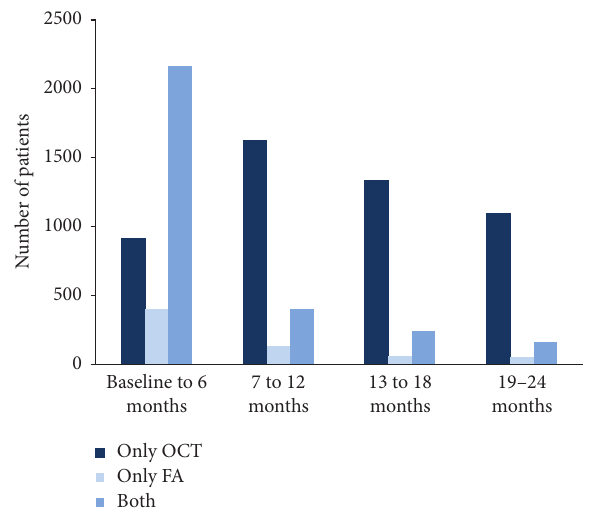
Figure 1: Number of patients receiving OCT, FA, and combined OCT+FA examinations per 6-month period of the OCEAN